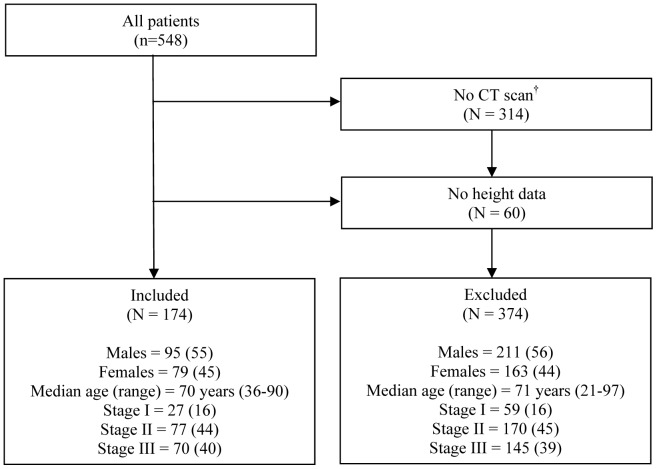
Flow chart representing the study selection process.
* All patients undergoing potentially curative resection of colorectal cancer Janueary 1st 2003 and December 31st 2010. † No CT scan stored in an electronic format suitable for image analysis.